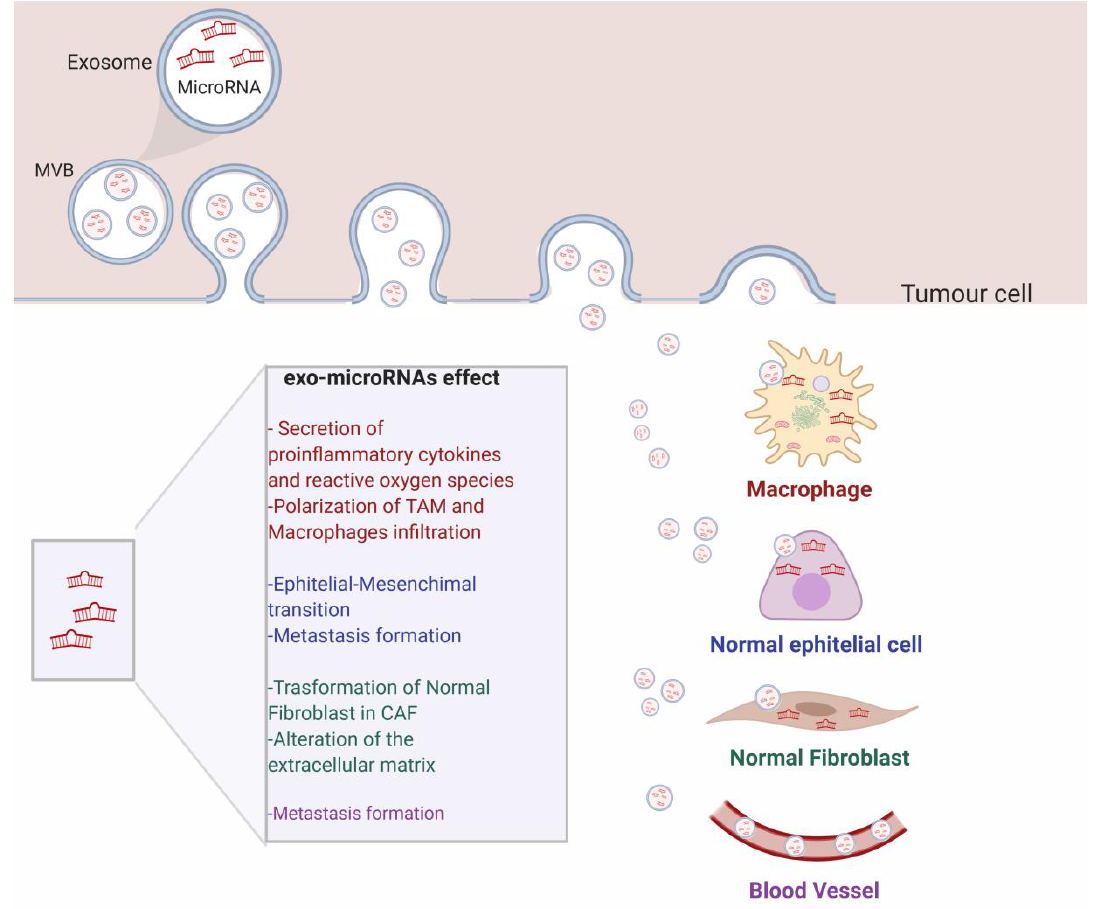
Figure 3. Schematic representation of the roles of exo-miRNAs on distant cells and in the cancer microenvironment. Exo-miRNAs released by tumor cells move to the extracellular space to reach near-by cells, such as macrophages, normal epithelial cells, and normal fibroblast. The exosomal cargo is responsible for cellular transformation and enhanced cancer progression . Exosomes can also reach distant cells, by moving along the blood stream.